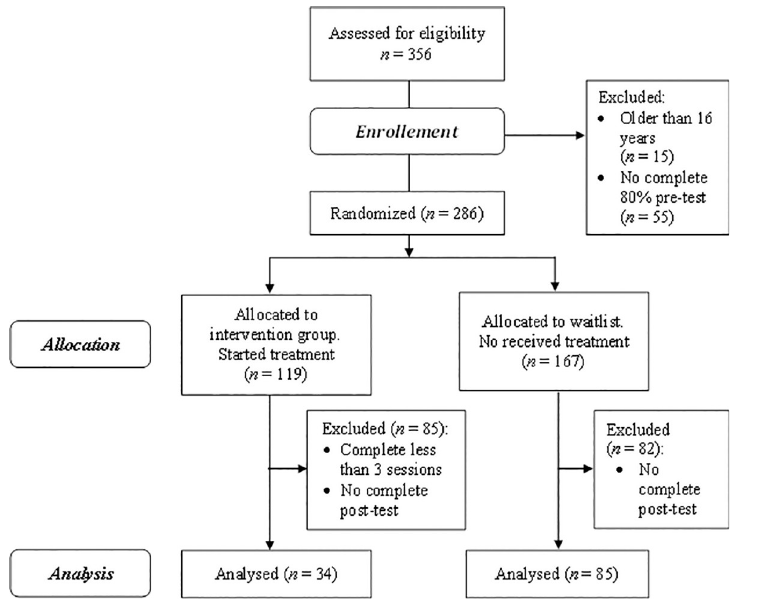
Fig 1. Flowchart of study participants and